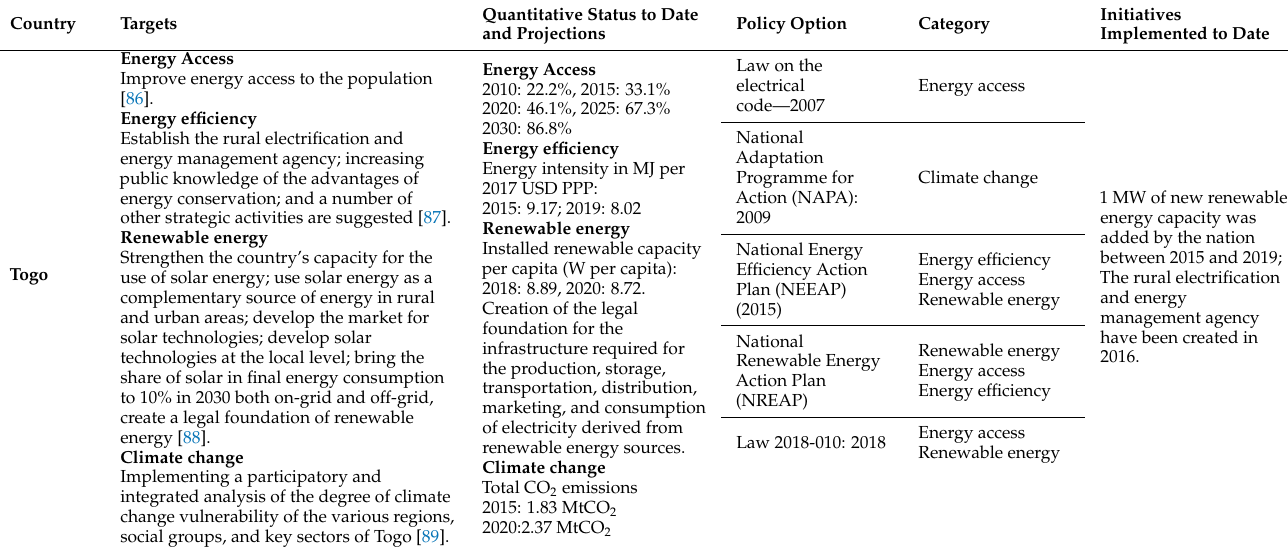
Table 15. Togo (data from